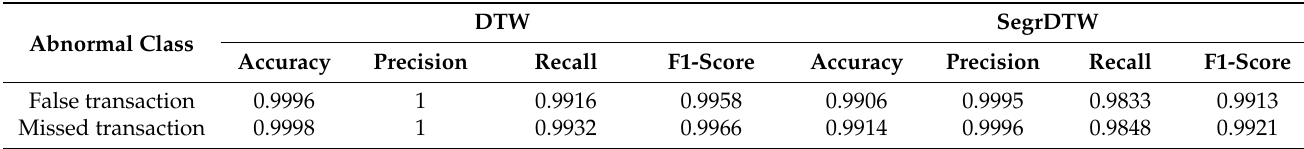
Table 5. The detection results for abnormal data